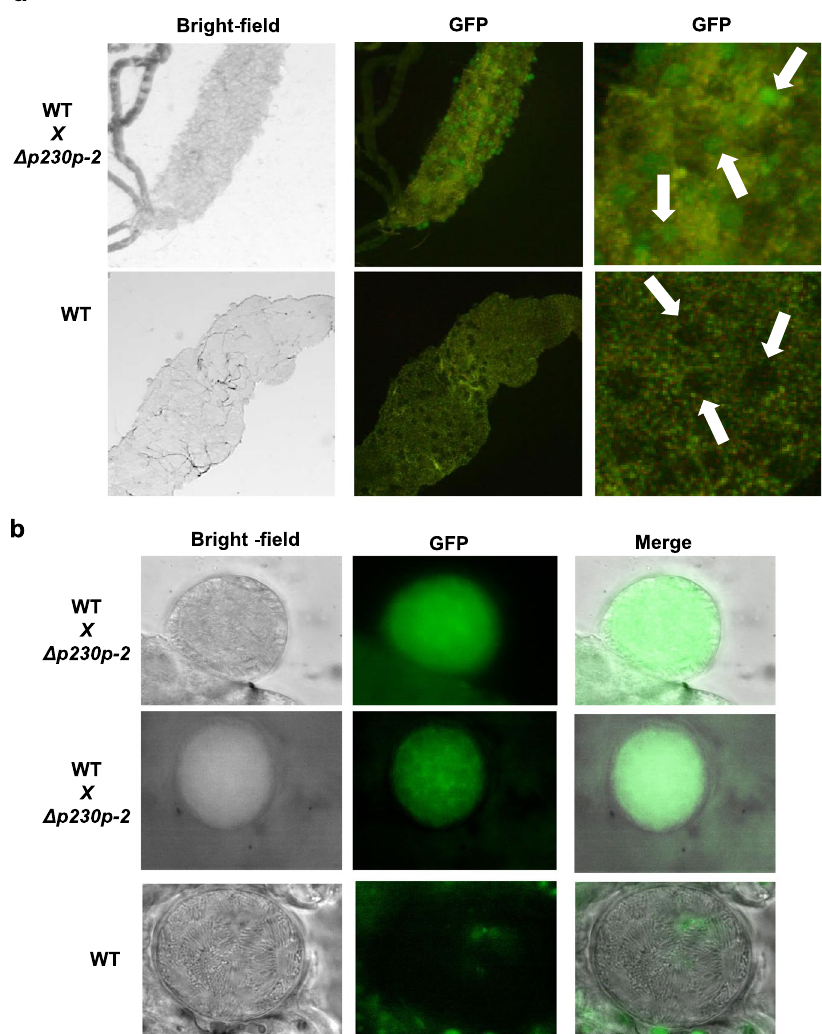
Figure 4. Crossing of GFP-expressing Pf Δ p230p gametocytes with WT gametocytes results in the formation of GFP-positive oocysts. ( a ) GFP-positive oocyst in midguts of A . stephensi mosquitoes fed on a mixture of Pf Δ p230p-2 and WT gametocytes (day 10 after feeding). Arrows indicate GFP-positive oocysts in the WT and Pf Δ p230p-2 cross and GFP-negative oocysts in WT fed mosquitoes. ( b ) GFP-positive and GFP-negative oocysts in mosquitoes fed on a mixture of Pf Δ p230p-2 and WT gametocytes or only WT gametocytes (day 10 after feeding). See Table 25 for the ratio of GFP-positive and GFP-negative oocysts in mosquitoes fed on a mixture of Pf Δ p230p-2 and WT gametocytes. All pictures were recorded with standardized exposure/gain times to visualize differences in fluorescence intensity (GFP 0.7 s; bright field 0.62 s (1x